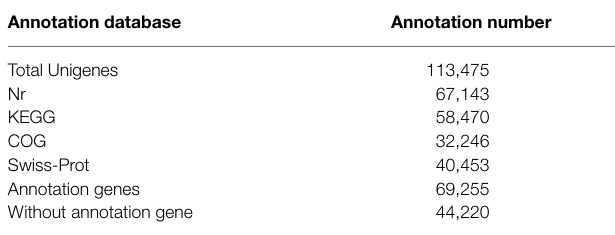
TABLE 1 | Summary for the BLASTx results of sugarcane transcriptome data